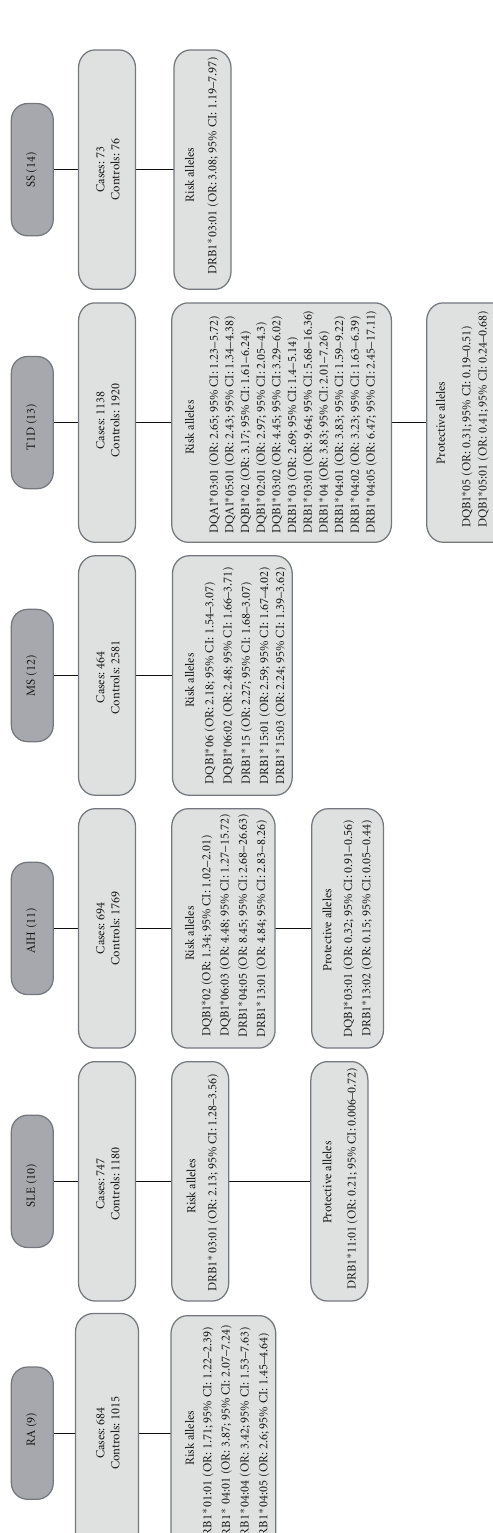
Figure 2: Previous results obtained from five meta-analyses and one original